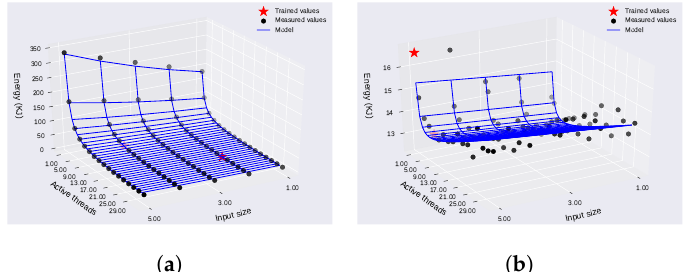
Figure 8. Example fit for a specific input size: Blackscholes ( a ) and Canneal ( b ). “measured values” are the sensor data and “minimum energy” is the minimum energy model prediction.